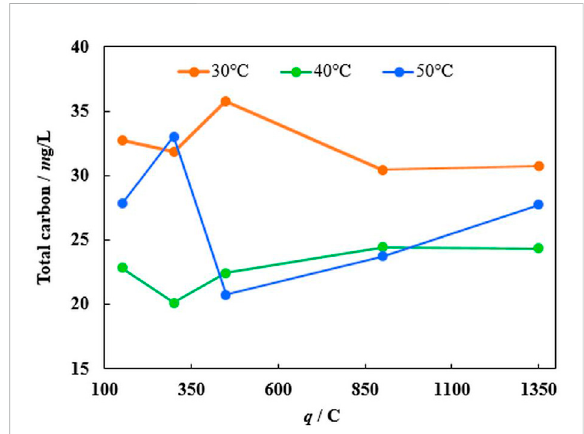
The dependence of total carbon amount after 10 min of